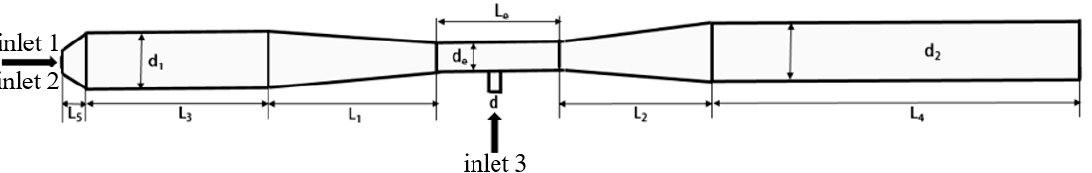
Figure 1. Dimension of jet-flow pyrolysis reactor (unit: mm). The total length of the jet reactor was 850 mm; the left gas-phase inlet has a fuel inlet (inlet 1) and an oxygen inlet (inlet 2) [4]. A chemical inlet (inlet 3) had a cross-section diameter of d = 10 mm, straight pipe cross-section diameters of d 1 = d 2 = 50 mm, the front throat straight pipe length was L 3 = 150 mm, a rear throat straight pipe length of L 4 = 300 mm, a throat diameter d e = 25 mm and length L e = 100 mm, and the variable diameter pipe lengths were L 1 = L 2 = 140 mm, L 5 = 20 mm. The outlet (outlet) section diameter was 50 mm.